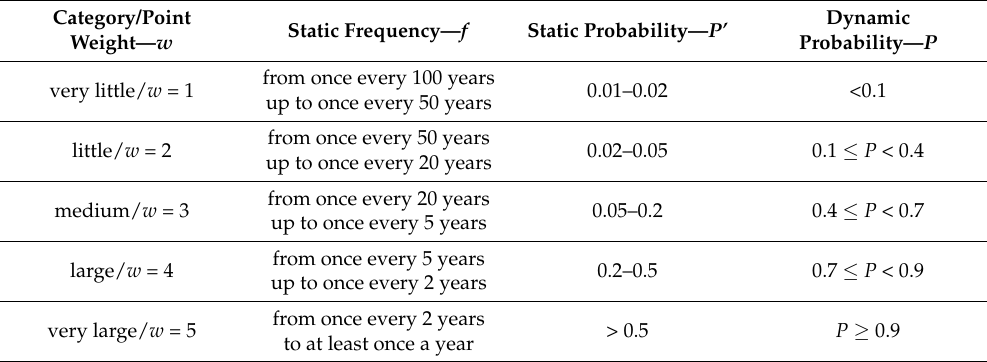
Table 1. Categories of frequency and probability of threat occurrence.